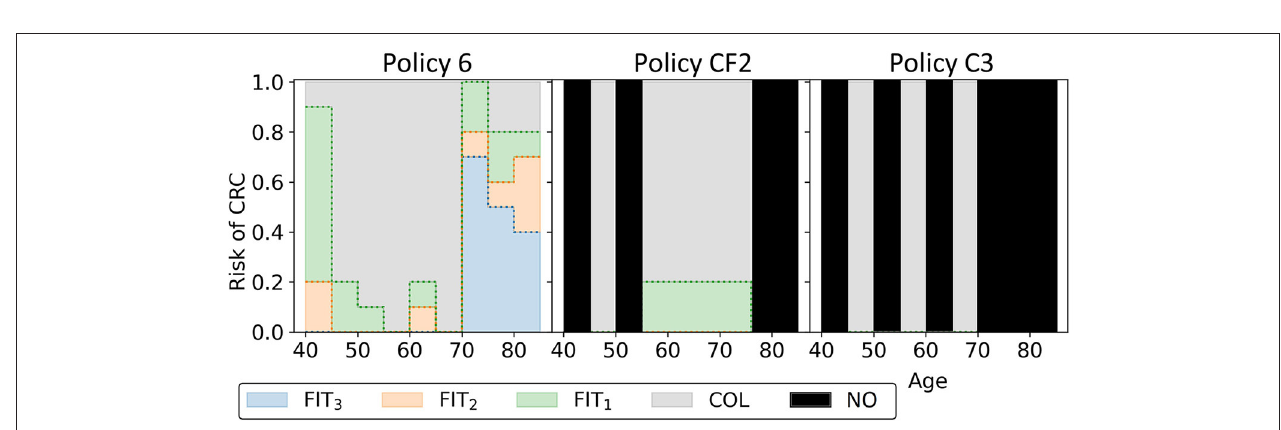
FIGURE 10 | The costs and QALYs of the reference policies and of the best approximation sets generated in Experiments 2 and 3. The blue line shows the best approximation set obtained in Experiment 2, the black line shows that of Experiment 3. The blue-red and black-orange policies in the approximation sets are cost-effective. The plus represents a situation without screening, the diamonds represent the policies evaluated for the USPSTF with FIT and/or colonoscopies that start at age 45. The two white diamonds are the two reference policies that are not dominated in Experiment 3. The four green-red/green-orange diamonds are referred to in Figures 11 , 14 .